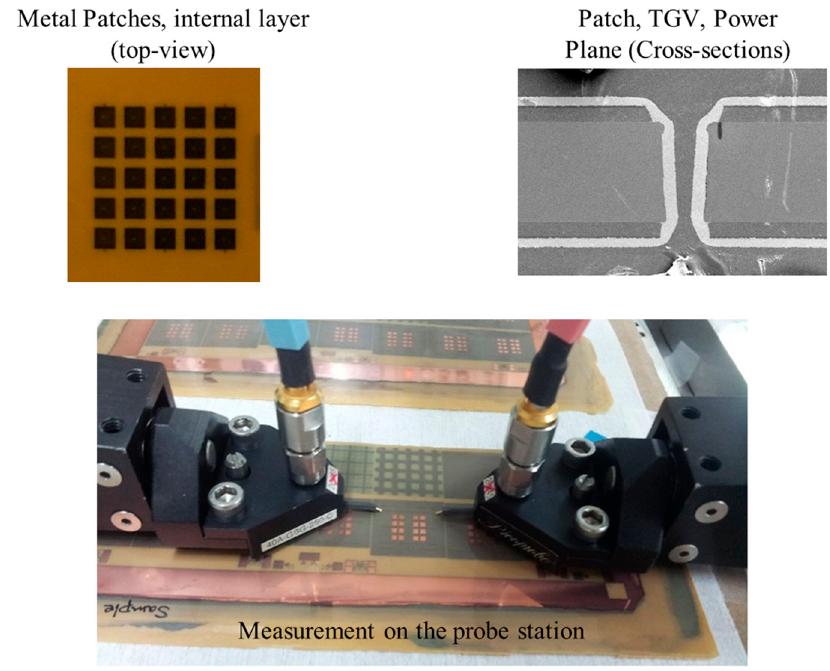
Figure 7. Measurement of fabricated glass interposer test vehicles.